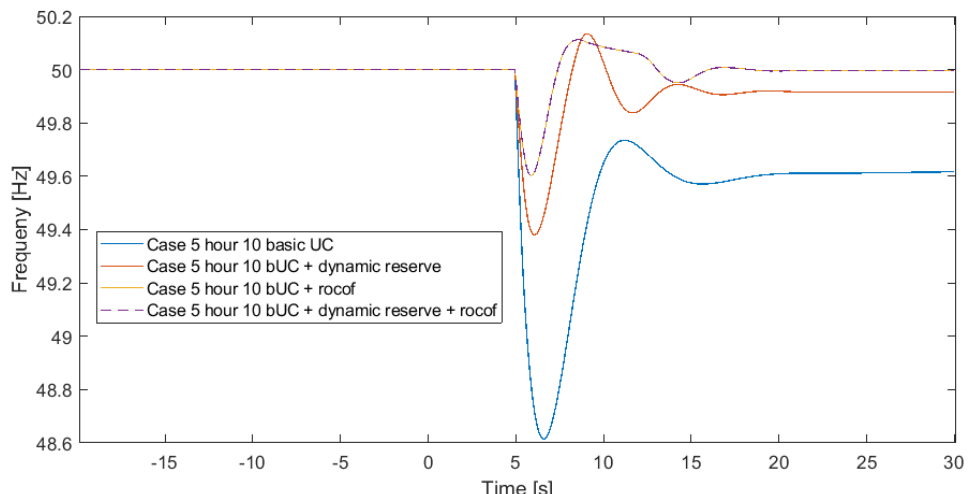
Figure 9. Case 5 at hour 10, post-contingency frequency behavior.